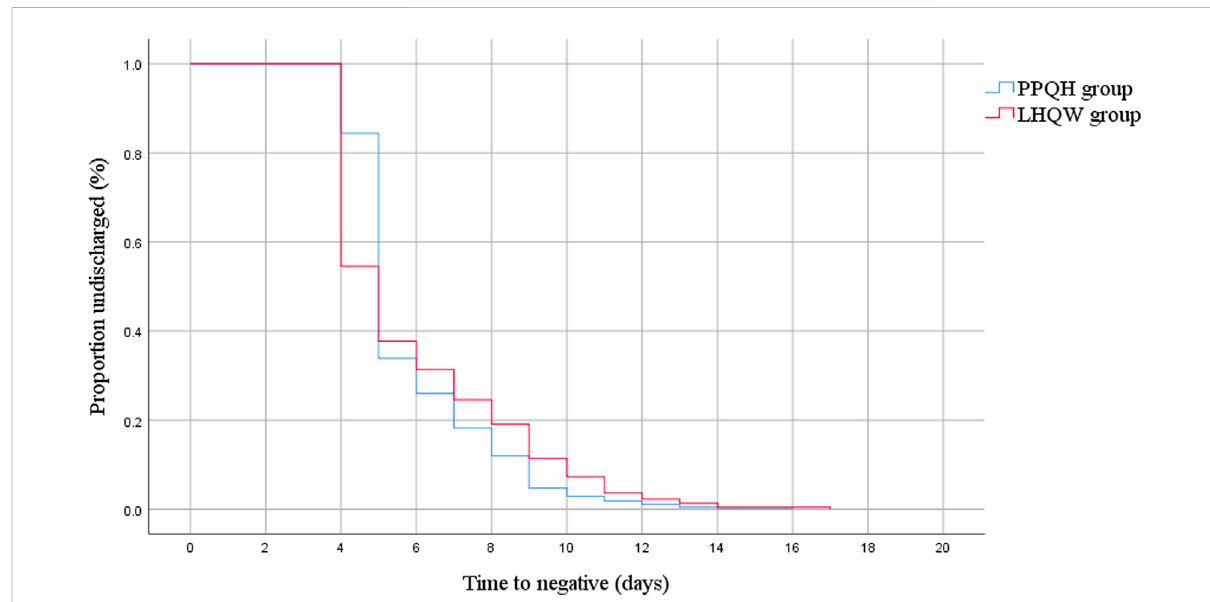
FIGURE 1 Kaplan – Meier estimate of the viral load shedding time between the two groups of SARS-CoV-2-infected patients.